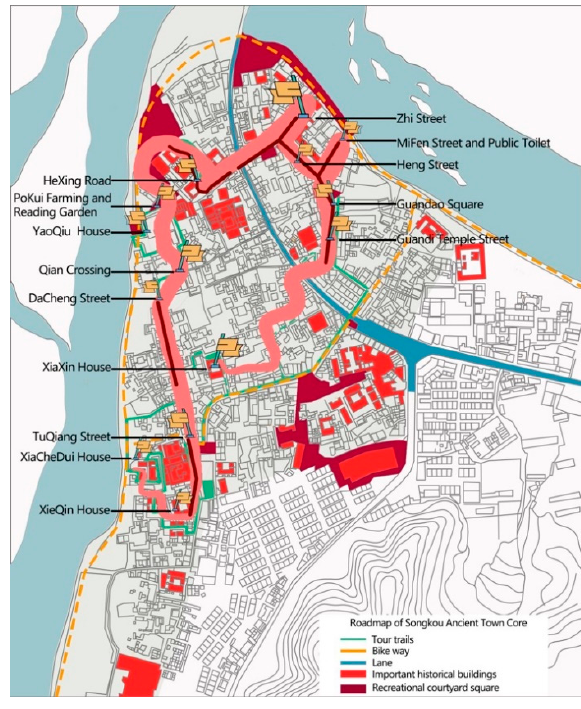
Figure 2. Map of Songkou ancient town core area.